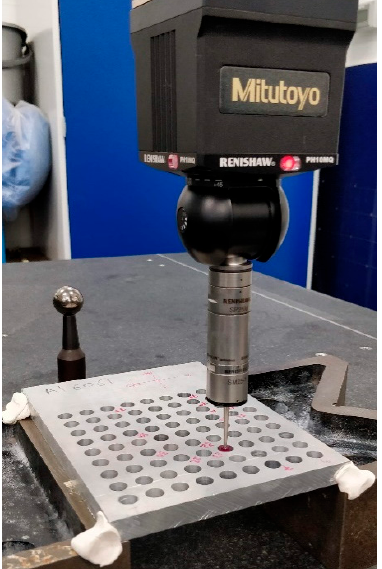
Figure 2. Al6061 workpiece setup inside the CMM machine.